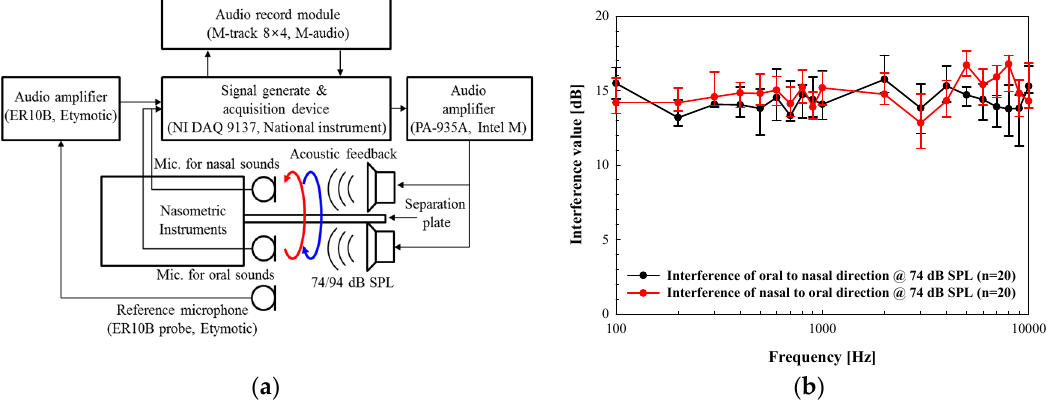
Figure 4. Experimental results: ( a ) block diagram and ( b ) the acoustic feedback effect.